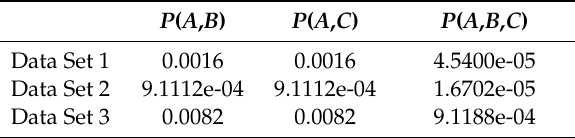
Table 3. The Friedman test